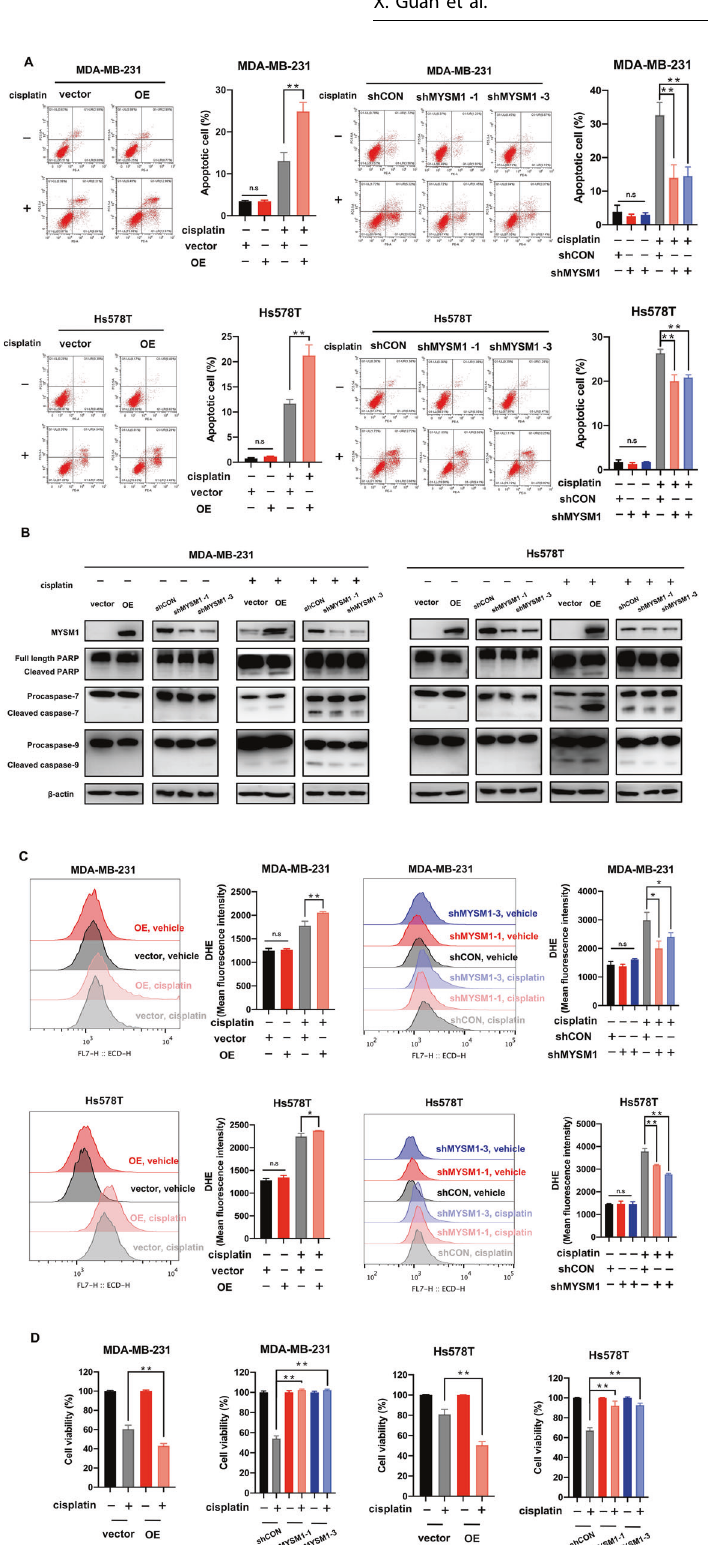
Fig. 3 MYSM1 increases cellular apoptosis, ROS production, and decreases cell viability upon cisplatin treatment. MDA-MB-231 and Hs578T cells with MYSM1 overexpression and knockdown and their corresponding negative control cells were treated with or without cisplatin (5 µg/mL) for 48 h. A Flow cytometry was performed to detect PE/Annexin V staining and evaluate apoptosis. B The cleaved PARP, full- length PARP, cleaved caspase-7, procaspase-7, cleaved caspase-9, and procaspase-9 were detected by western blot. C Flow cytometry was performed to detect DHE staining and evaluate ROS production. D CCK8 assay was performed to measure cell viabilities. All data in the graph bars represent means ± SD. * P < 0.05 and ** P <